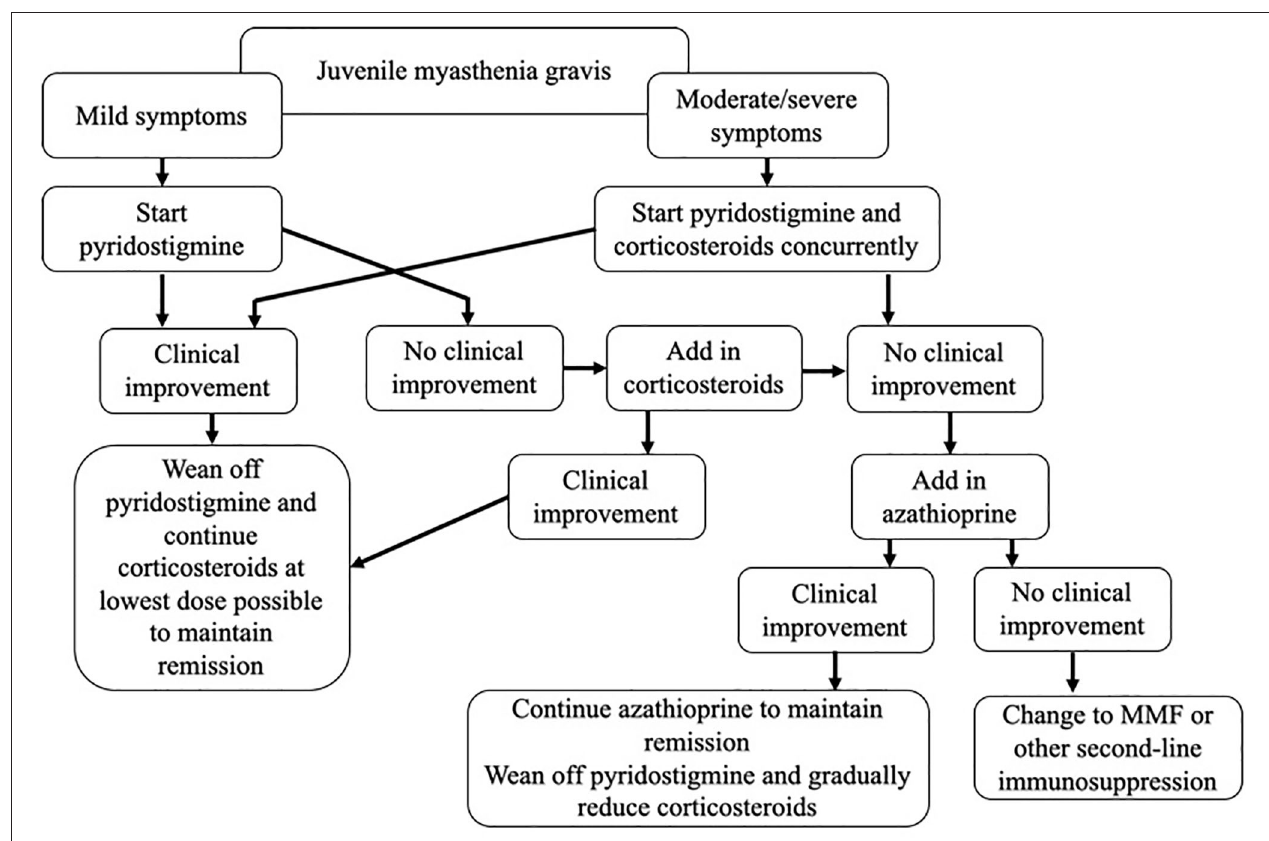
FIGURE 1 | Our approach to pharmacologic therapy in juvenile myasthenia